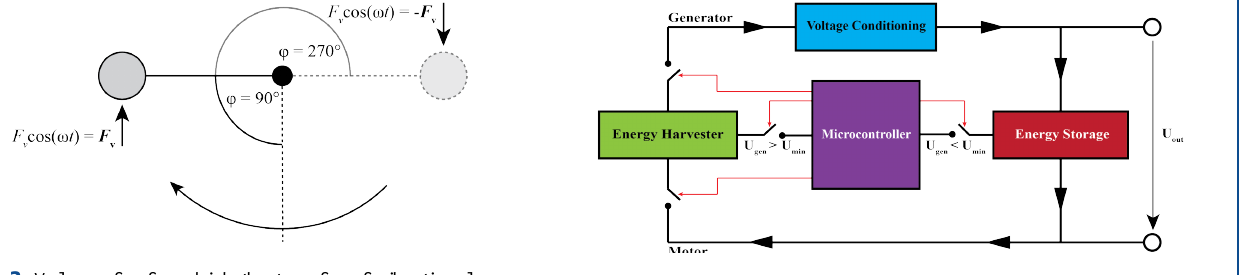
Figure 4. Block diagramm of the system layout.